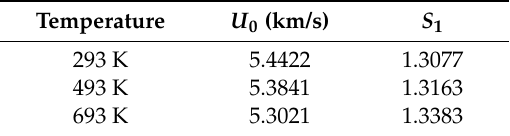
Figure 5. Laser shock properties as a function of the particle velocity under different temperatures. ( a ) Shock velocity; and ( b ) shock pressure. Table 1. Parameters in Hugoniot relations for laser shock wave under different temperatures.